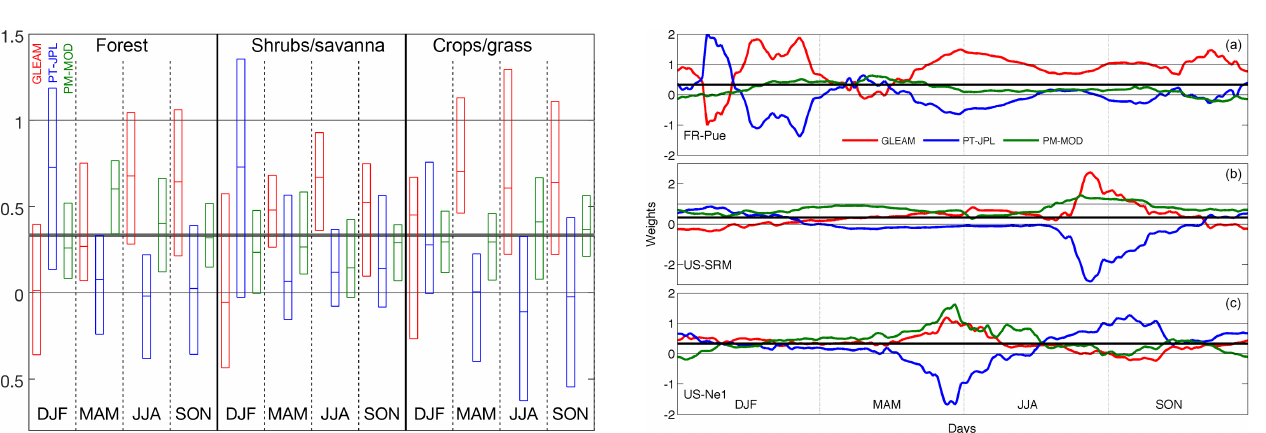
Figure 5. Example of GLEAM (red), PT-JPL (blue), and PM- MOD (green) weights at the FR-Pue (top, forest), US-SRM (mid- dle, grassland), and US-Ne1 (bottom, cropland) stations. The thick black line marks the one-third value of the SA-merger weights; the thin black lines mark the 0–1